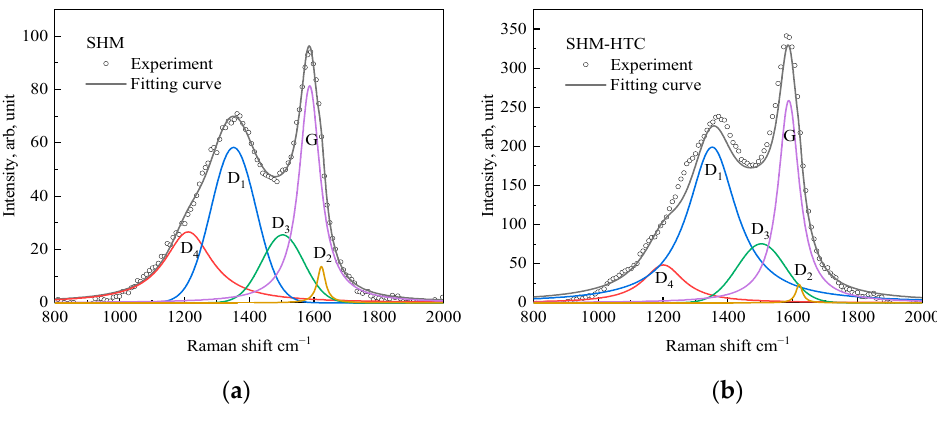
Figure 3. Raman peak fitting results of: ( a ) SHM and; ( b ) SHM-HTC. Table 2. Calculation results of Raman structure parameters of different samples.